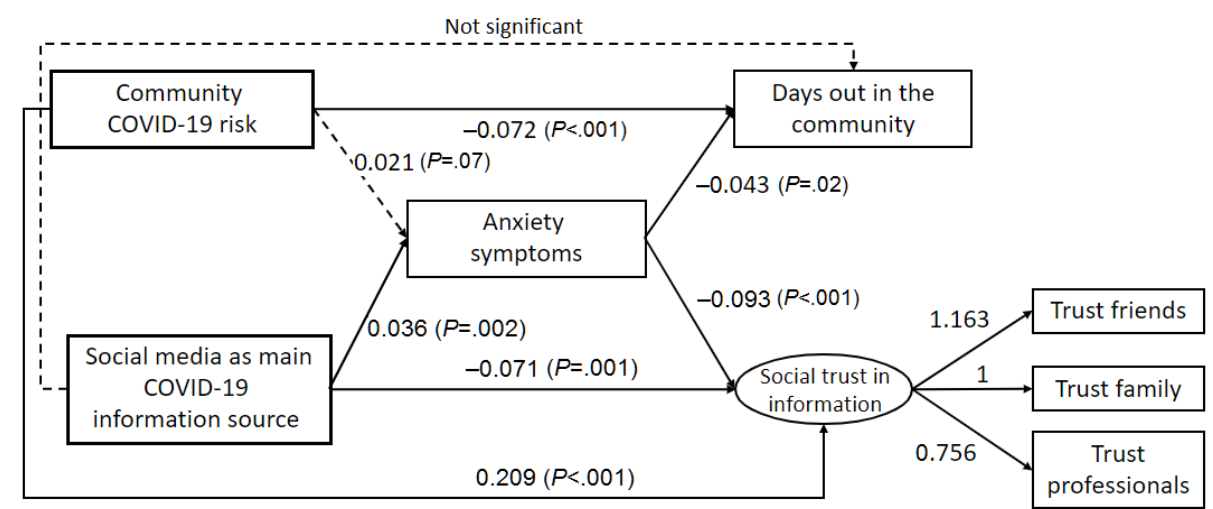
Figure 2. Structural equation modeling. Standardized parameter estimates are